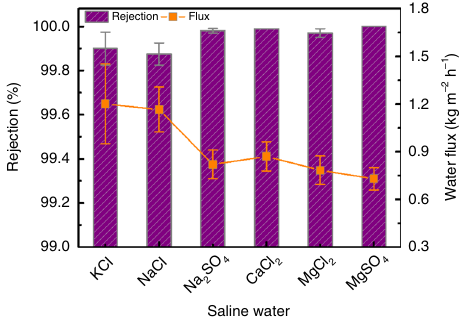
Fig. 7 Desalination of saline water over ED-GO@PSSHF membrane. The concentration of saline aqueous solutions is 0.1 mol L − 1 and the vacuum membrane distillation temperature is 60 °C; error bars derived from